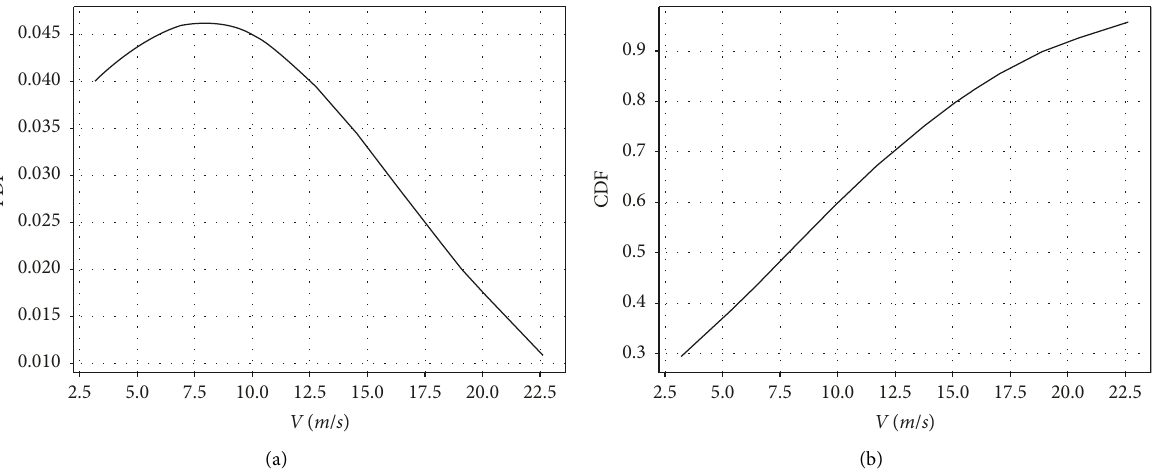
Figure 19: (a) Rayleigh probability distributions function PDF and (b) Rayleigh cumulative distributions function